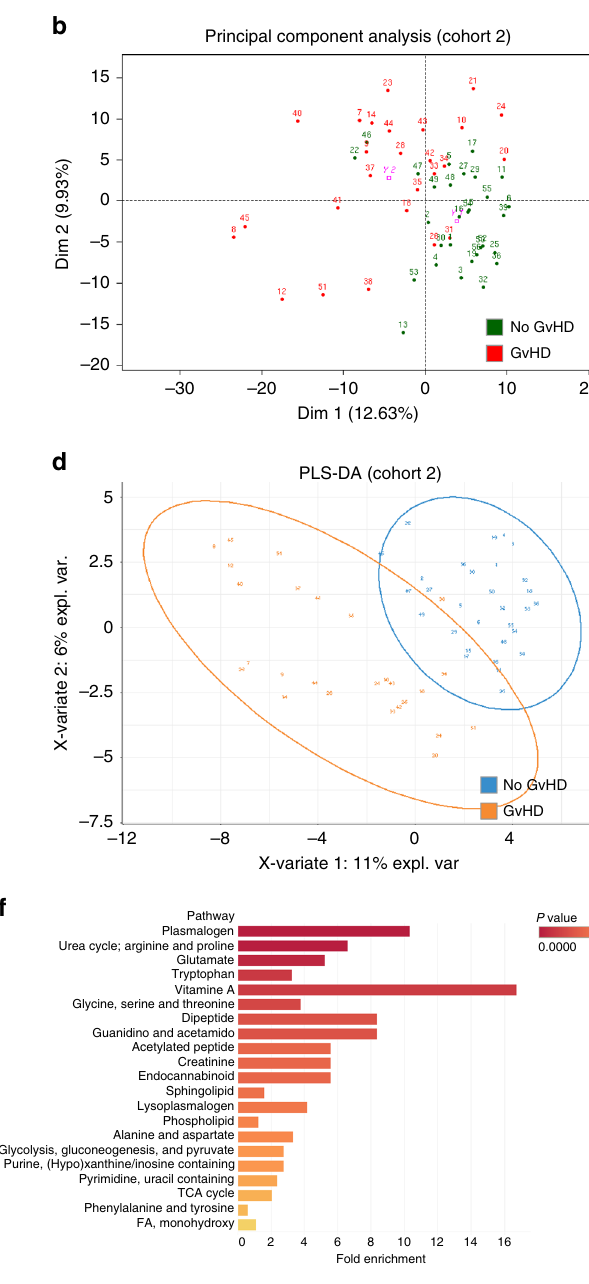
con fi rmatory analysis used the same fi lters and procedures than the exploratory analysis to assess whether the results obtained in the fi rst cohort of patients were consistent in an independent cohort. To ensure the comparability of the results, both analyses used only the 653 metabolites that were shared by the two datasets (excluding 150 metabolites detected only in the Saint Louis cohort and 274 metabolites detected only in the Cryostem cohort). Unless speci fi ed, all analyses were done using a 5% type I error rate ( p <0.05, after multiplicity correction when required). To handle obvious confounders, all analyses of steps two and three (detailed below) were secondly adjusted. More speci fi cally, unpaired analyses were adjusted for age, sex, and BMI. Analyses on paired cases (either D vs Rs, or D vs Ra) were adjusted for differences of age and of BMI, as well as for sex match between the two subjects of the pair. For paired